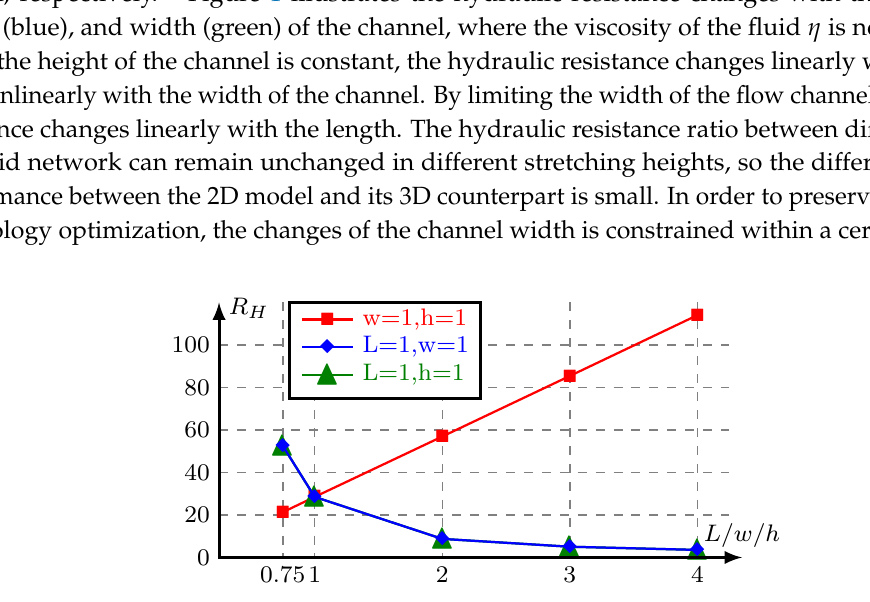
Figure 1. The hydraulic resistance changes with the length (red), height (blue), and width (green) of the channel, η = 1